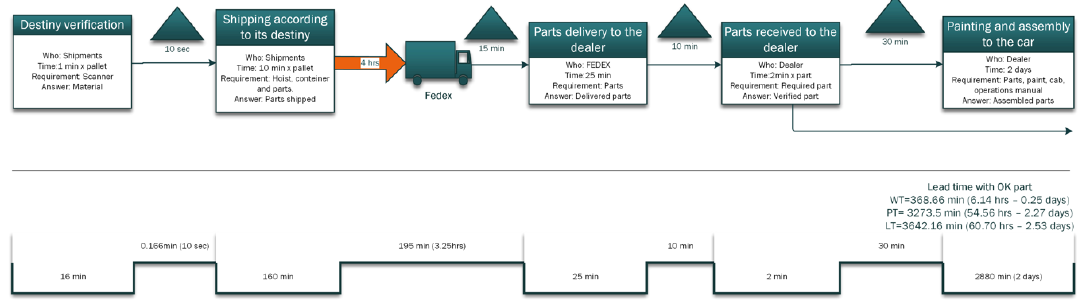
Figure 21. The third part of four of the future state map is displayed.